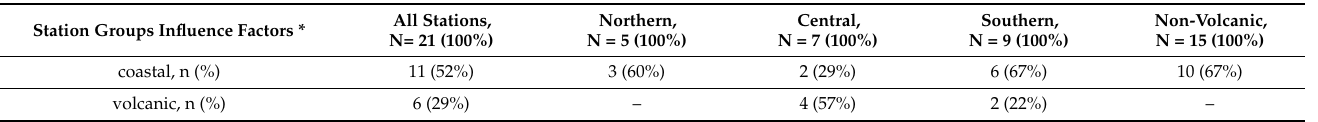
Table 2. Distribution of stations into groups, taking into account the number of stations affected by sea waves (coastal stations) and volcanic activity (volcanic